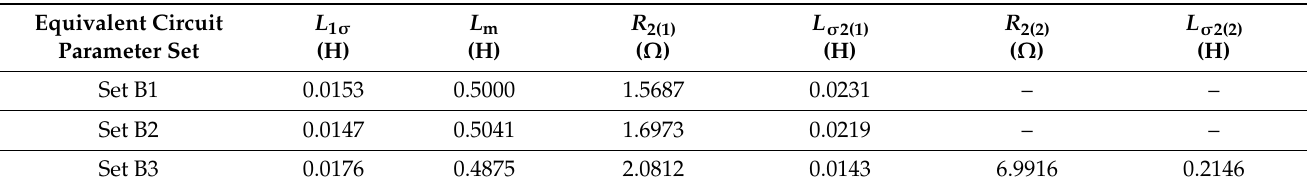
Table A2. The equivalent circuit parameter sets of the tested CR IM. The resistances were corrected to the reference winding temperature of 25 ◦ C.